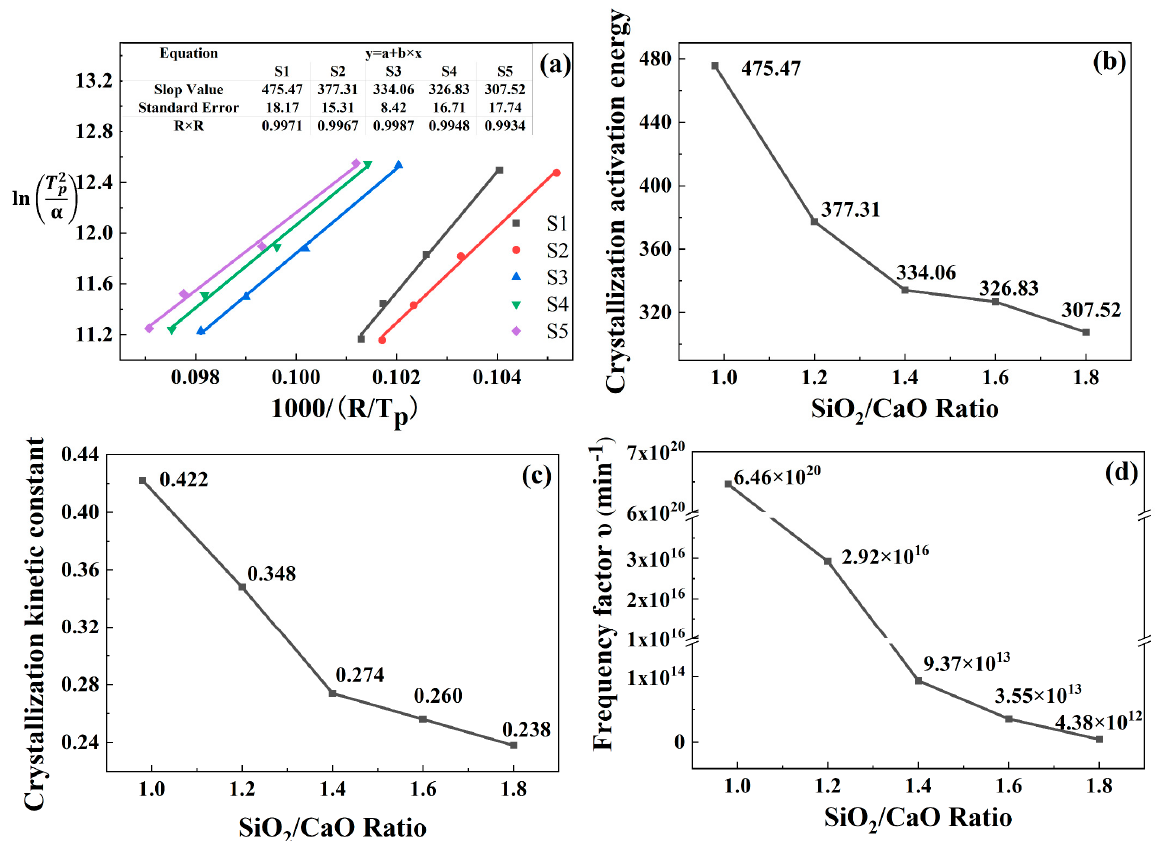
Figure 6. ( a ) Relationship between ln ((cid:1846) (cid:3043)(cid:2870) /α) and 1000/((cid:1844) × (cid:1846) (cid:3043) ) , relationship between SiO 2 /CaO ratio with E c ( b ), k ( c ), υ ( d ). ratio with E c ( b ), k ( c ), υ ( d